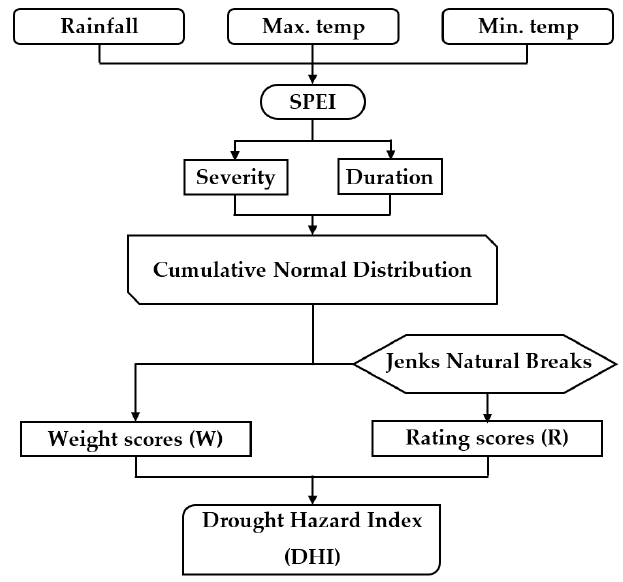
Figure 3. Steps used for estimating the Drought Hazard Index (DHI).